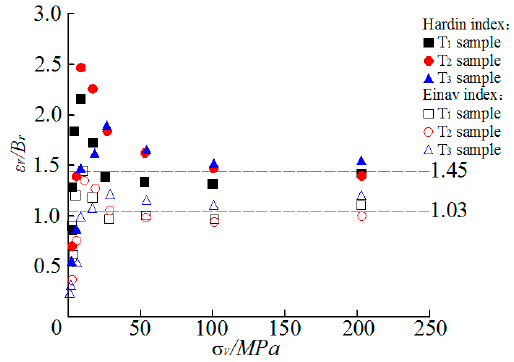
Figure 11. Evolution of ε v / B r with stress level.